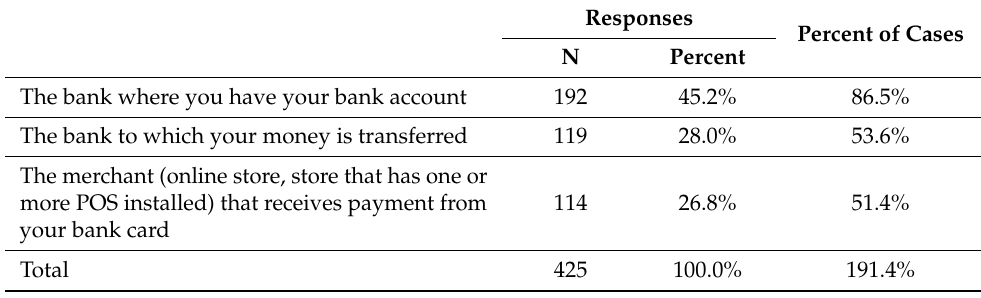
Figure 5. Distribution of the sample based on responsibility for fraud detection—boxplot. Source: Authors’ processing in SPSS 24. Table 3. Who is responsible for fraud detection—analysis of the multiple response set for the 5 score.